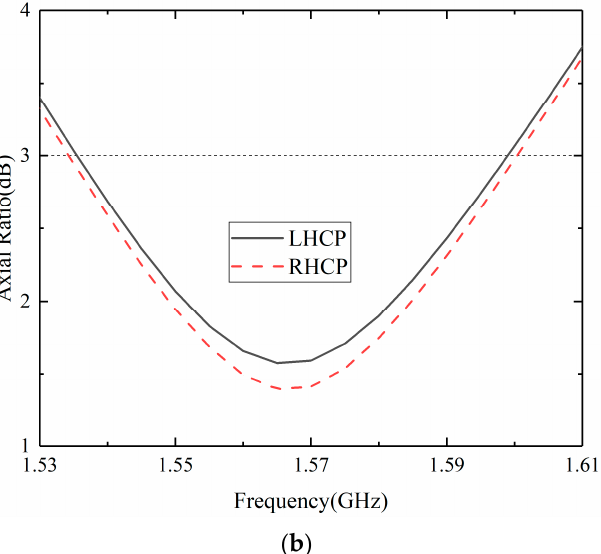
Figure 5. The simulated ( a ) radiation pattern and ( b ) axial ratio of the NDCPPA model’s element. The proposed NDCPPA model verification prototype was composed of 3 ments introduced above, and the element spacing was 100 mm (0.5